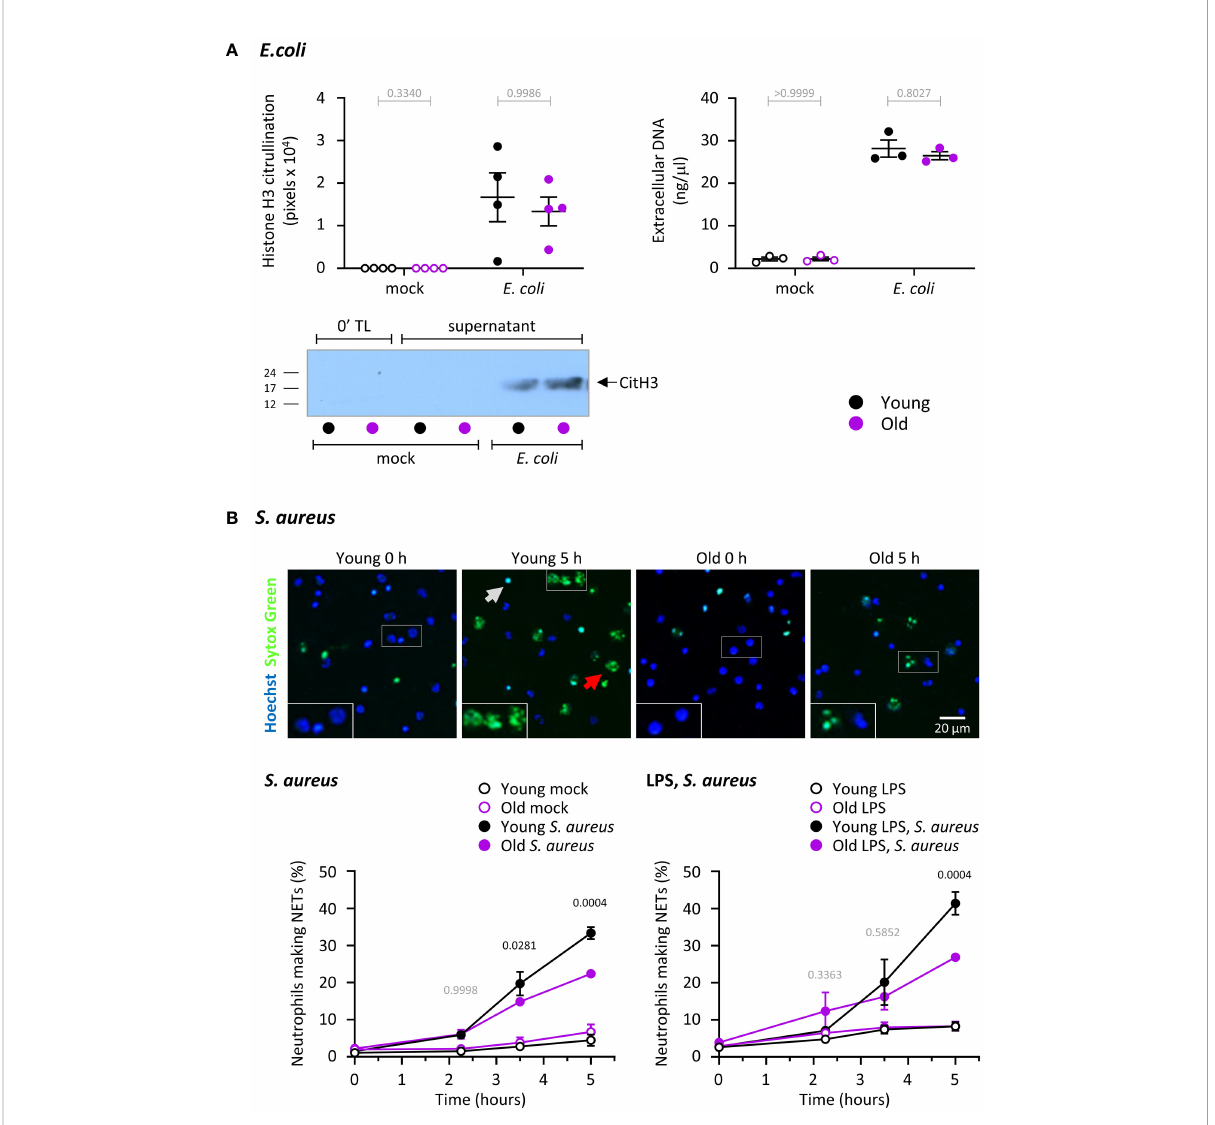
FIGURE 5 Hornigold K et al. NET release in response to S. aureus but not E. coli is impaired in neutrophils from old mice, independently of LPS. (A) NET release in response to E. coli . Release of DNA and citrullination of histone H3 were measured in the same samples as in Figure 4A to test NET release in neutrophils from young (8-10 weeks, black symbols) and old (24 months, purple symbols) mice in response to E. coli . DNA in cell pellets and cell supernatants was quantitated by spectrometry, and citrullinated H3 by western blotting. A representative blot from one experiment is shown. Data are mean ± SEM of 3-4 independent experiments, as indicated; each dot represents the mean of one experiment. Statistics (two-way ANOVA) revealed no differences between the ages (grey p-values). (B) NET release in response to S. aureus . Neutrophils from young and old mice were primed with 1 m g/ml LPS or mock-primed for 90 min at 37°C, seeded onto glass slides and allowed to adhere for 30 min at 37°C before stimulation with serum-opsonised S. aureus (10 bacteria per neutrophil; fi lled symbols), or mock stimulation (open symbols), for the indicated periods of time. Non-cell permeable Sytox Green and cell permeable Hoechst DNA dyes were added to samples 15 min before the end of incubation, and cells were live-imaged by wide fi eld microscopy. (A) Representative images of mock-primed neutrophils from one experiment stimulated with S. aureus for the indicated lengths of time. The grey arrow indicates a dead cell, the red arrow a NET. (B) NETosis was quantify by ImageJ, using Sytox Green signal to identify NETs, and phase contrast and Hoechst signal to count total cells. Data are mean ± SEM of 7 independent experiments with mock-primed cells (left-hand panel) and 3 with LPS-primed cells (right-hand panel). Statistics are two-way ANOVA with Sidak ’ s multiple comparisons test. P-values denote signi fi cant differences between S. aureus - stimulated cells from young and old mice; black p-values are signi fi cant, grey p-values non-signi fi